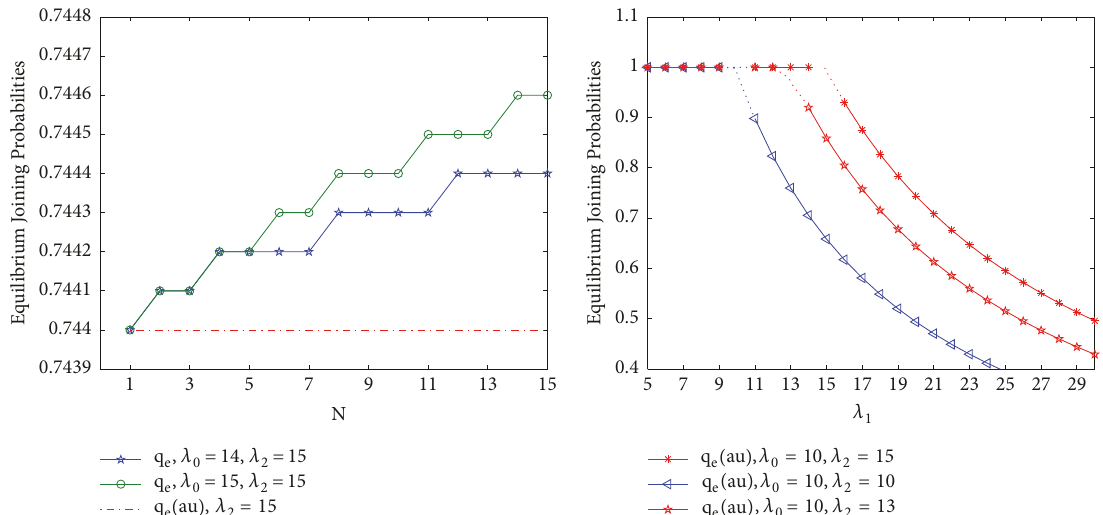
Figure 5: Left: equilibrium joining probabilities for the almost and fully unobservable cases vs. 𝑁 for 𝑅 = 30; 𝑝 1 = 5; 𝐶 1 = 3; 𝜆 1 = 20. Right: rquilibrium joining probabilities for the almost and fully unobservable cases vs. 𝜆 1 for 𝑅 = 30, 𝑝 1 = 5, 𝐶 1 = 3, 𝑁 = 5. 0.460.480.50.520.540.560.58